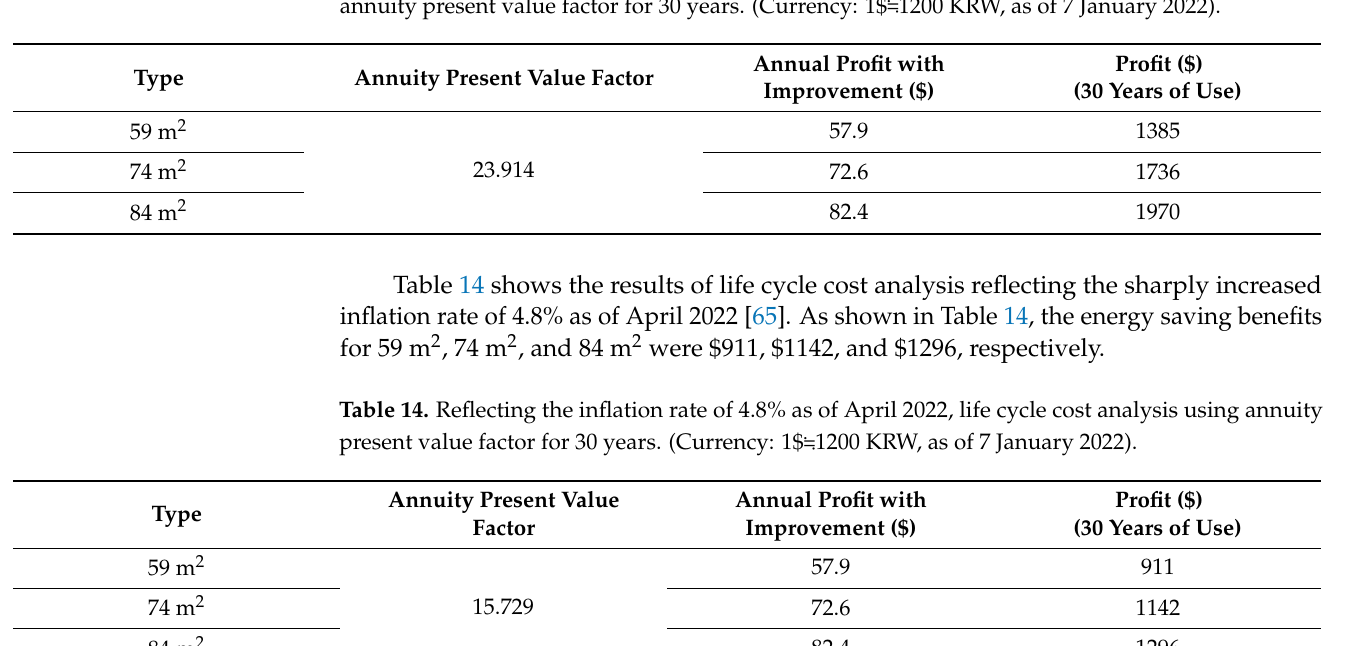
Table 13. Reflecting an average inflation rate of 1.53% for 2012–2021, life cycle cost analysis using Table 11. Energy cost of district heating energy and electricity for the M complex before and after